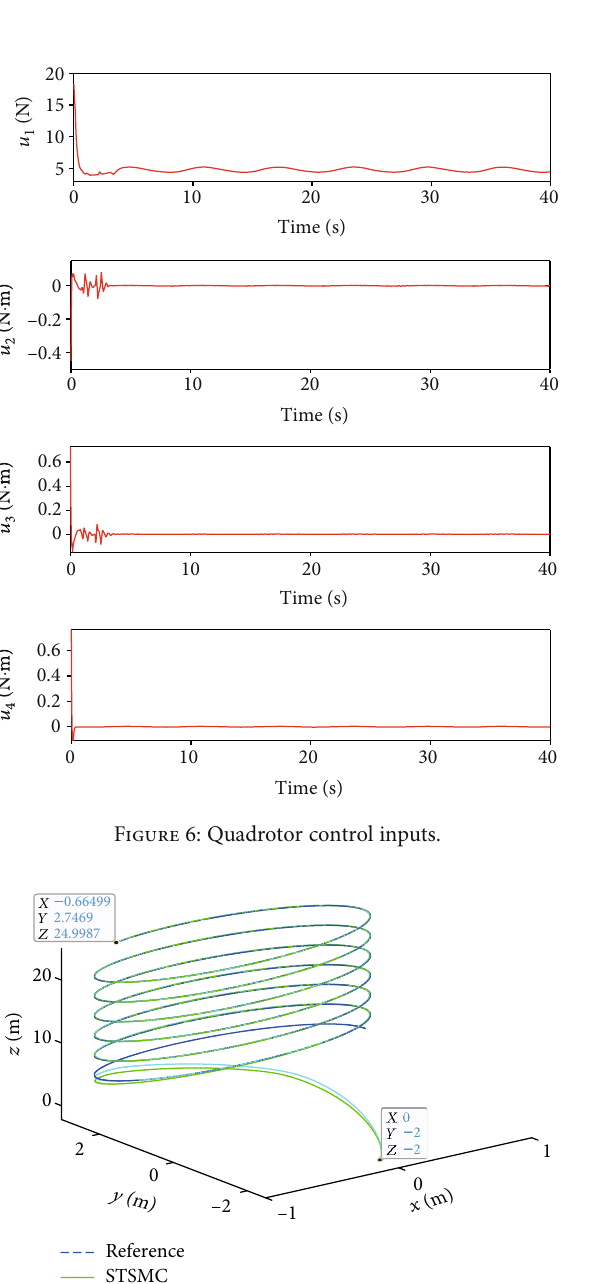
Figure 7: Quadrotor 3D trajectory tracking.